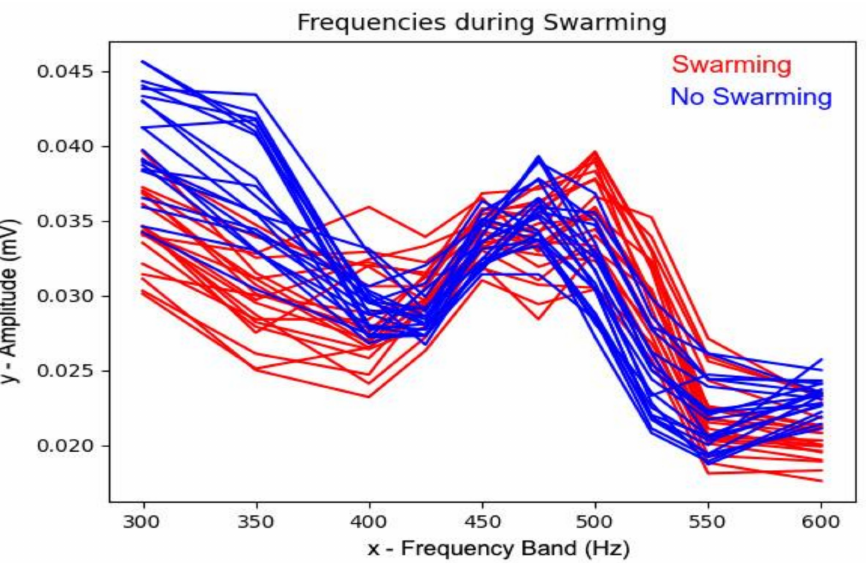
Figure 6. Amplitude response in mV RMS ten days before the swarming event over the frequency band of 300–600 Hz (using 10/25 Hz frequency